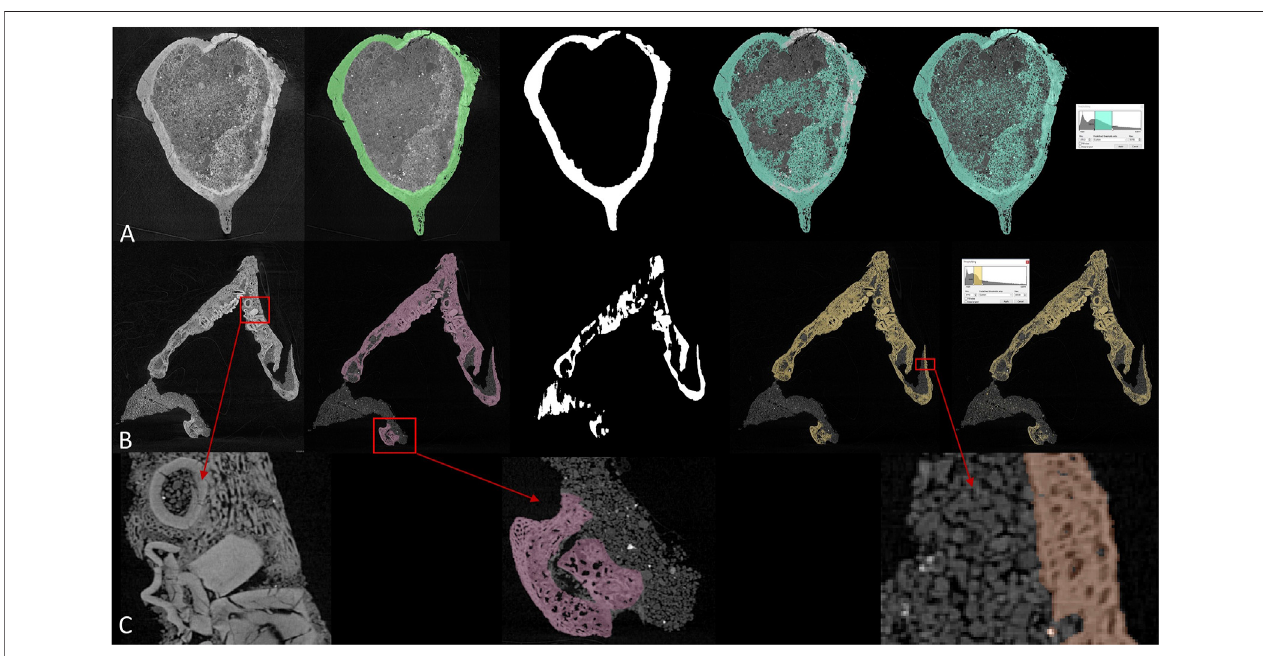
FIGURE 2 | Comparison between different segmentation methods in (A) brain endocast of Protoceratops and (B) toothed lower jaw of Protoceratops , from left to right: CT slice, manual segmentation, U-net, region growing, and thresholding. (C) detailed structure in toothed area in dentary and fossil-rock boundaries.